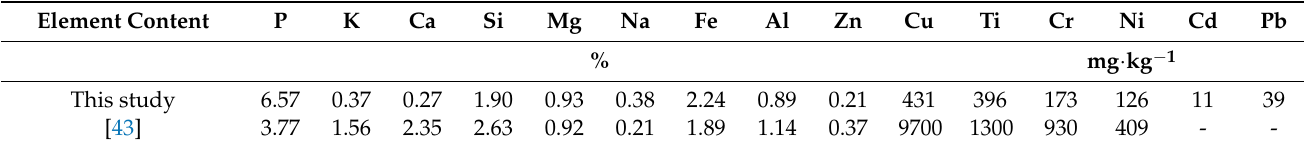
Table 2. Content of selected inorganic components in sewage sludge.